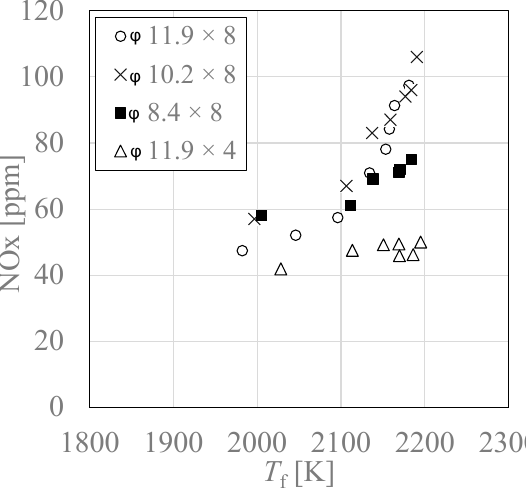
Figure 15. NOx for different T f without accounting for EGR at 1273 K. Input = 174 kW. λ = 1.2, P = +15 Pa. E H2 = 0, 50, 80, 85, 90, 95, 100%.